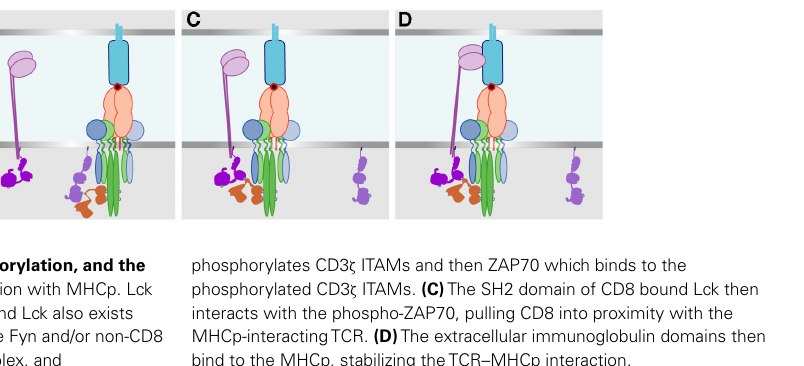
FIGURE 1 |A model for initiation ofTCR – CD3 phosphorylation, and the recruitment of the co-receptor. (A) BeforeTCR interaction with MHCp. Lck and/or Fyn are associated with the plasma membrane, and Lck also exists associated with CD8. UponTCR binding to MHCp (B) the Fyn and/or non-CD8 bound Lck becomes associated with theTCR–CD3 complex, and